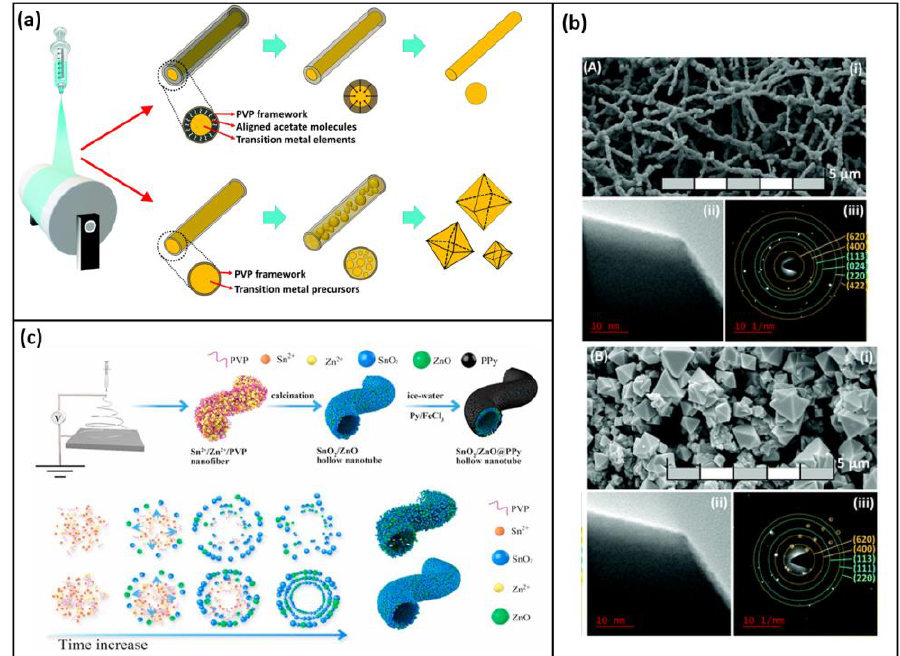
Figure 8. ( a ) Aligned acetate molecules assisted nanostructure formation. (reused with copyrights from Ref. [92] 2022, Elsevier) ( b ) (i) FESEM, (ii) HRTEM, (iii) SAED of the (A) NCM Nanofiber and (B) NCM Octahedron with instruments FESEM, JOEL, JSM-7800F, USA, operating at 30 kV, a TECNAI G2 20 TWIN, FEI-USA respectively (reused with copyrights from Ref. [92] 2022, Elsevier) ( c ) Illustration of fabrication of SnO 2 /ZnO@PPy.s (reused with copyrights from Ref. [93] 2021, Elsevier).